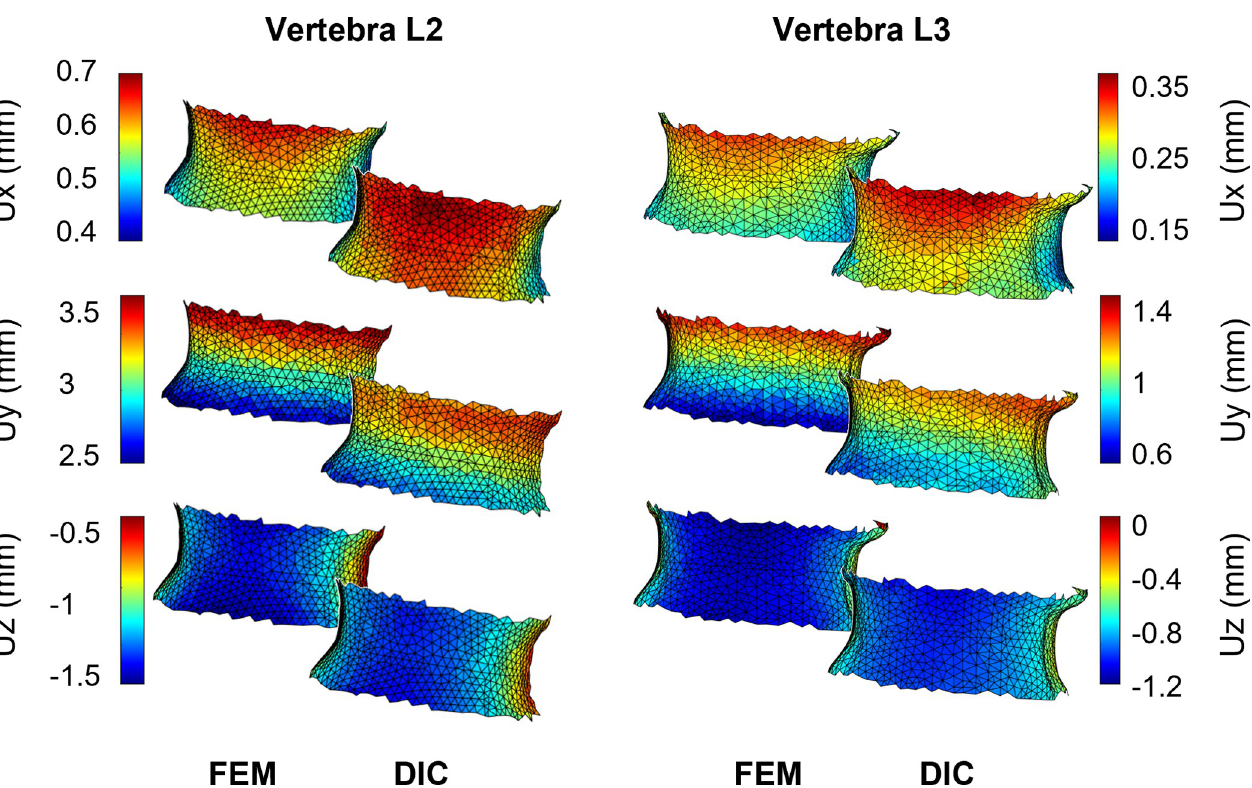
Fig 7. Displacement field of the two vertebral surfaces. Comparison between computational and experimental displacement fields in the three directional components X, Y and Z for each vertebra (L2 left, L3 right). To help the reader in appreciating the comparison, both experimental and computational displacements have been interpolated over the same